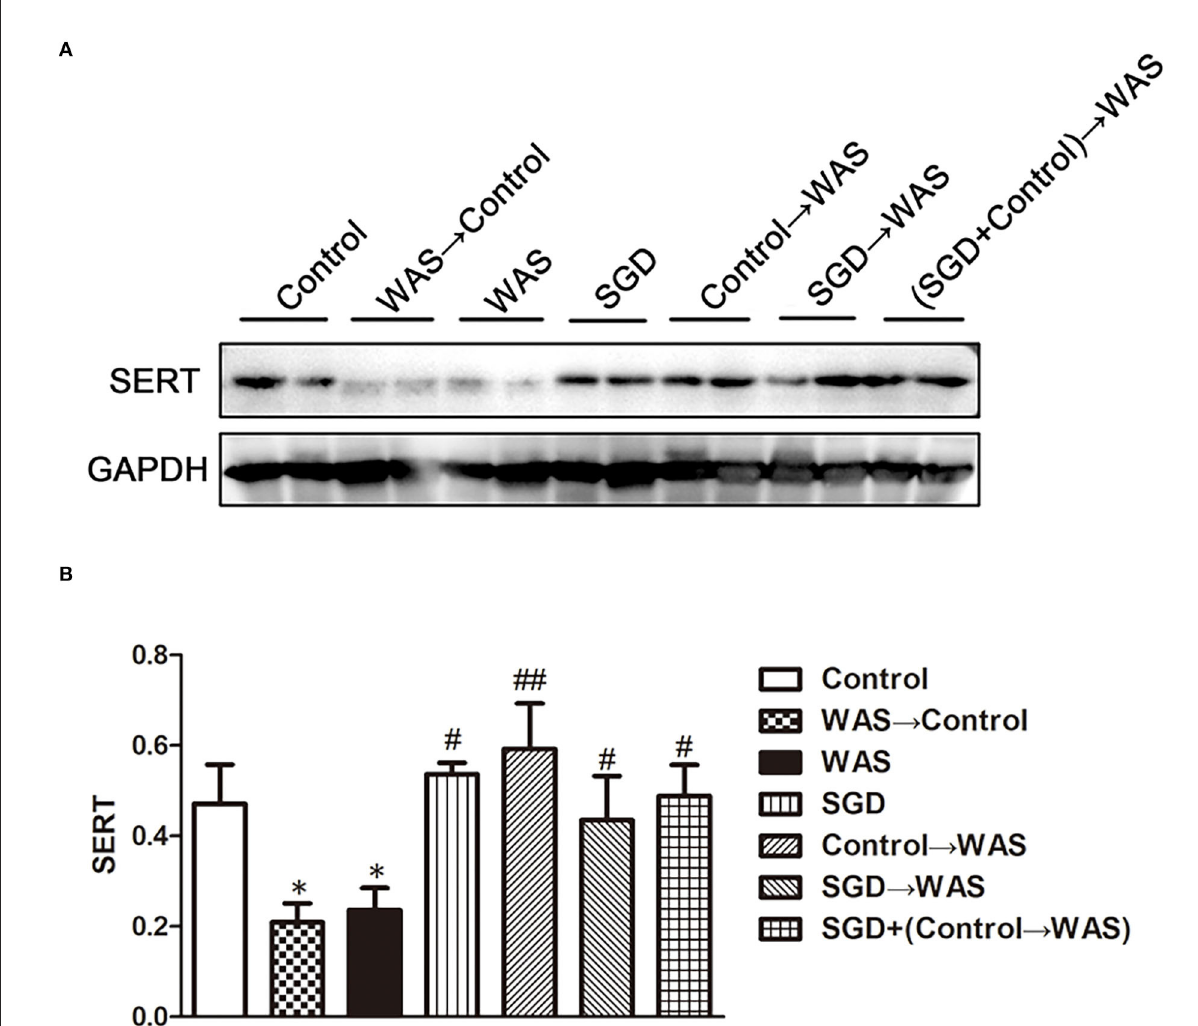
FIGURE6 Effects of several FMT combined with or without SGD on SERT expression in the colon of rats. (A) SERT protein expression plot in the colon. (B) Statistical plot of SERT protein expression in the colon (All results are expressed as mean ± SE n = 3/group, * P < 0.05 vs. Control, # P < 0.05 vs. WAS, ## P < 0.01 vs.